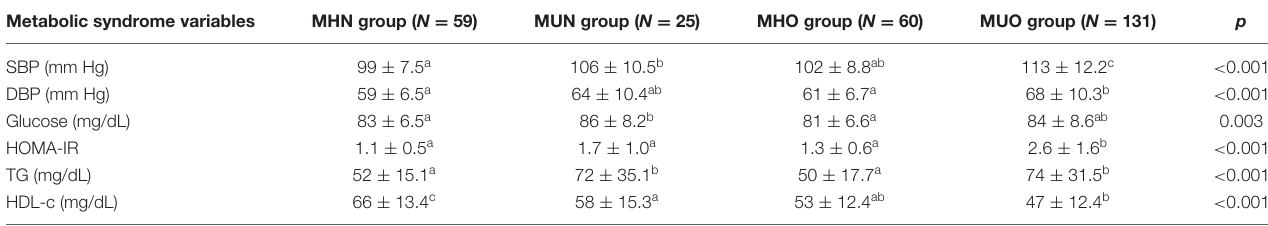
TABLE 2 | Measurements of metabolic risk markers in prepubertal children according to metabolically healthy or unhealthy status and normal or overweight/obesity. Metabolic syndrome variables MHN group ( N = 59) MUN group ( N = 25) MHO group ( N = 60) MUO group ( N = 131) p